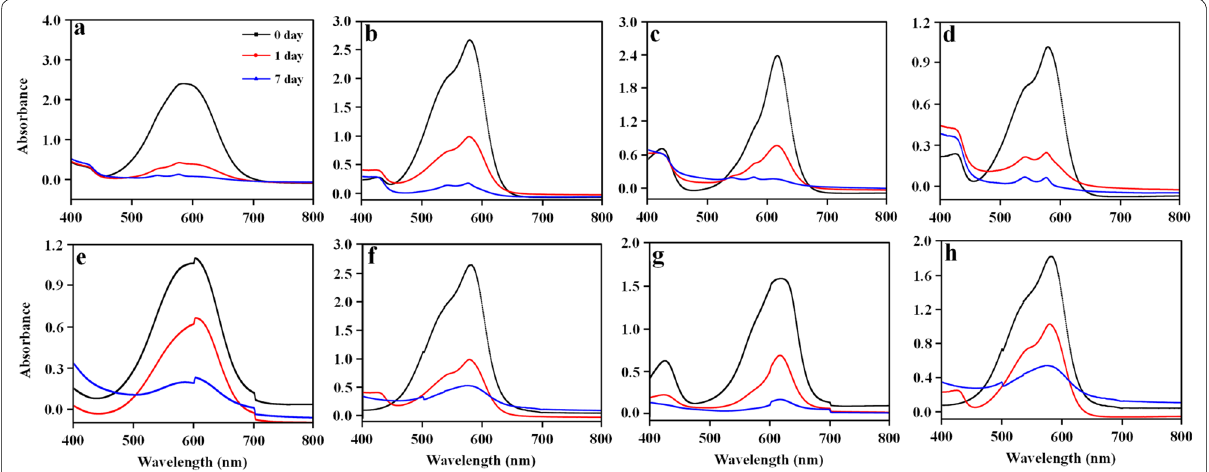
Fig. 4 The UV–vis spectrum analysis derived from a CB cells, g MG